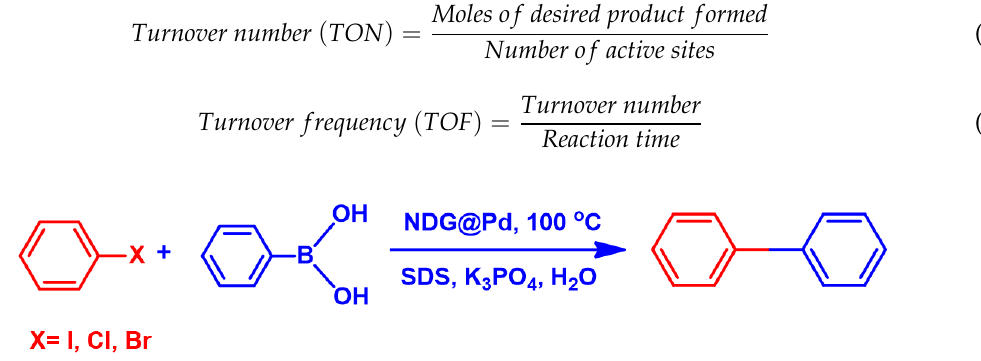
Figure 9. Schematic representation of the Suzuki reaction of iodobenzene, bromobenzene, and chlorobenzene with phenylboronic acid under aqueous conditions.